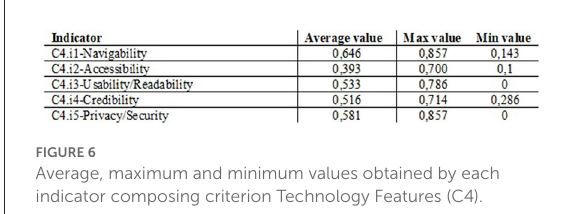
FIGURE6 Average, maximum and minimum values obtained by each indicator composing criterion Technology Features (C4).